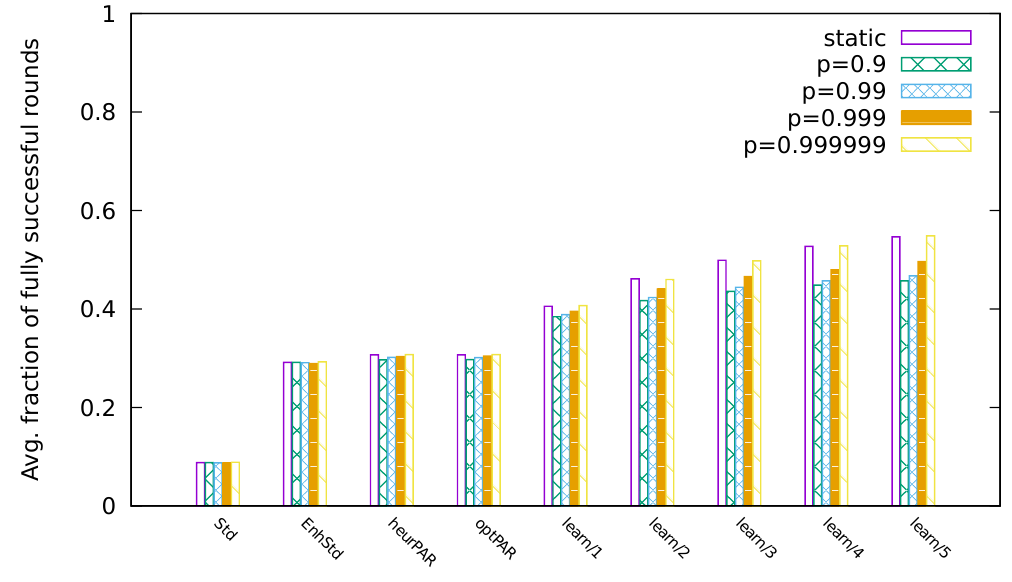
Figure 4. Average fraction of successful